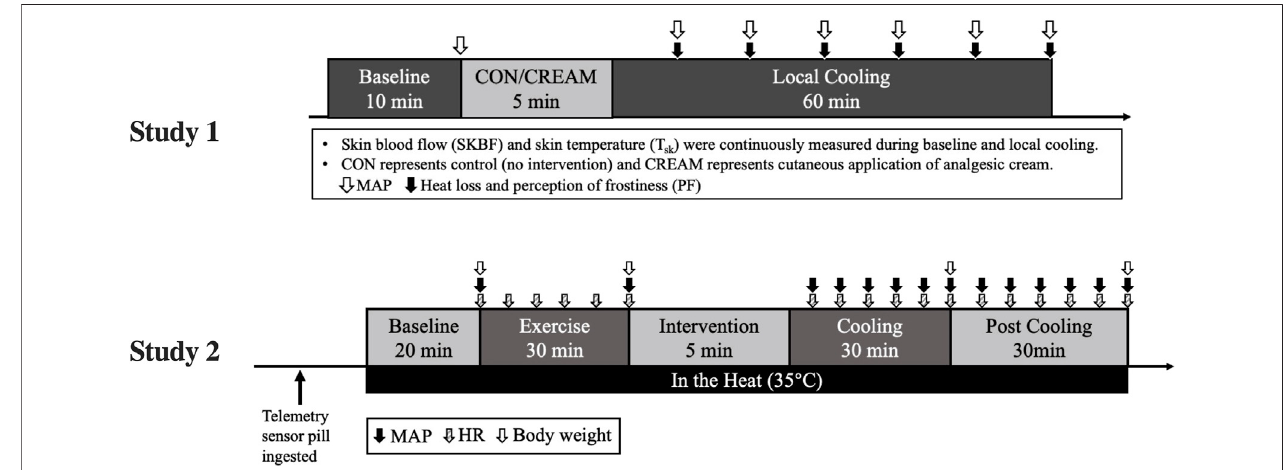
FIGURE1 | The experimental design. MAP, meanarterialpressure; HR,heartrate;CON, control cooling; CREAM, cooling with cutaneous applicationofanalgesic cream.